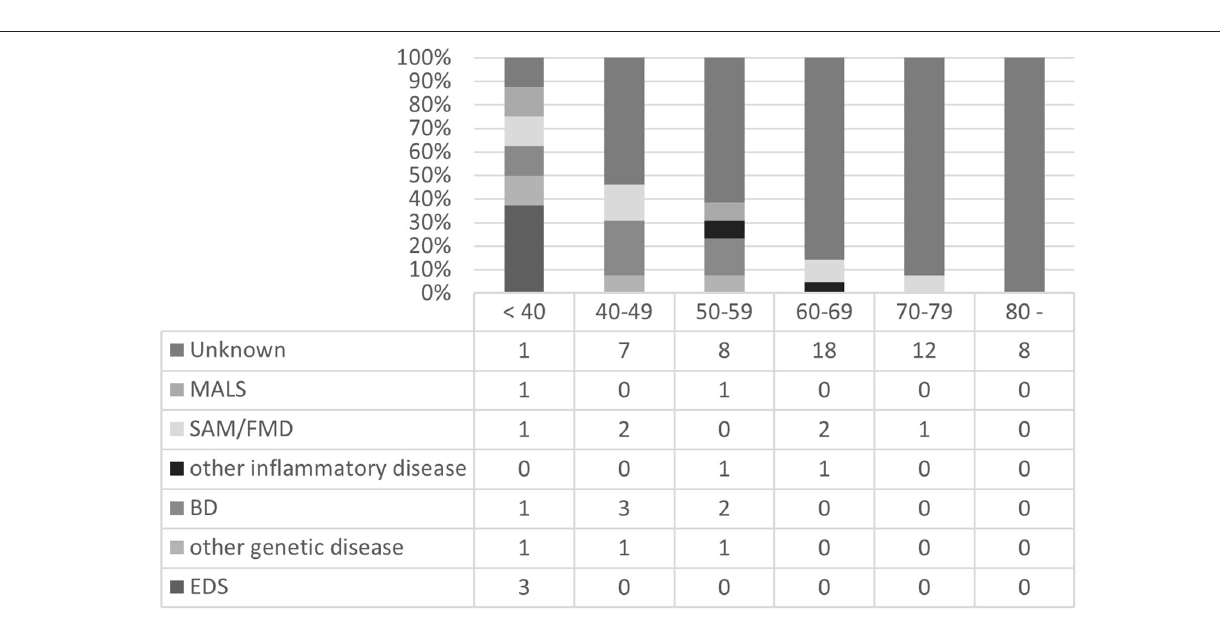
Frontiers in Surgery |